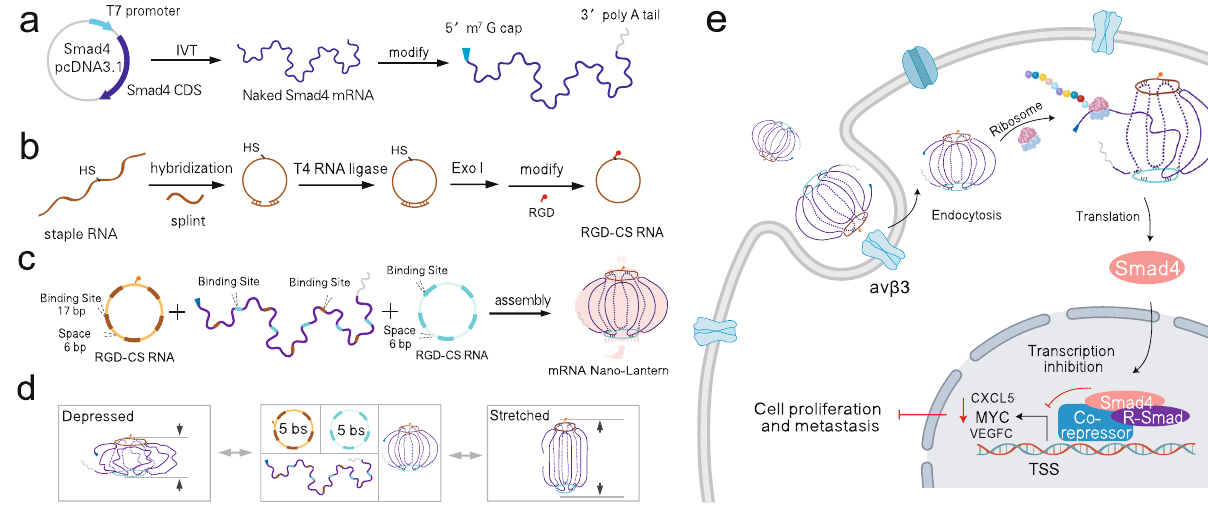
Fig. 1 | Schematic illustration of Smad4 mRNA nano-lantern. a Synthesis and modi fi cation of Smad4 mRNA. b Synthesis of RGD-modi fi ed circular staple RNA. c Construction of lantern-shaped fl exible origami. d Possible structures of the